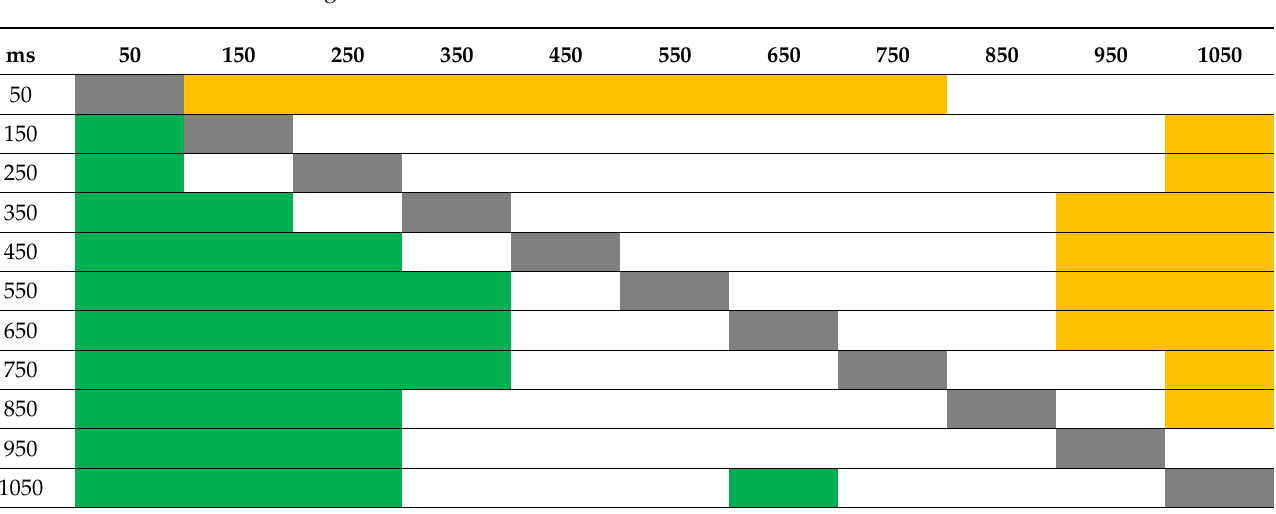
Table A2. Statistical significance between window sizes for WL algorithm. Green indicates statistically significant difference ( p < 0.05; Bonferroni-corrected) for the RMSE metric, and orange indicates significant difference ( p < 0.05; Bonferroni-corrected) for the cross-correlation metric. Grey indicates diagonal fields.